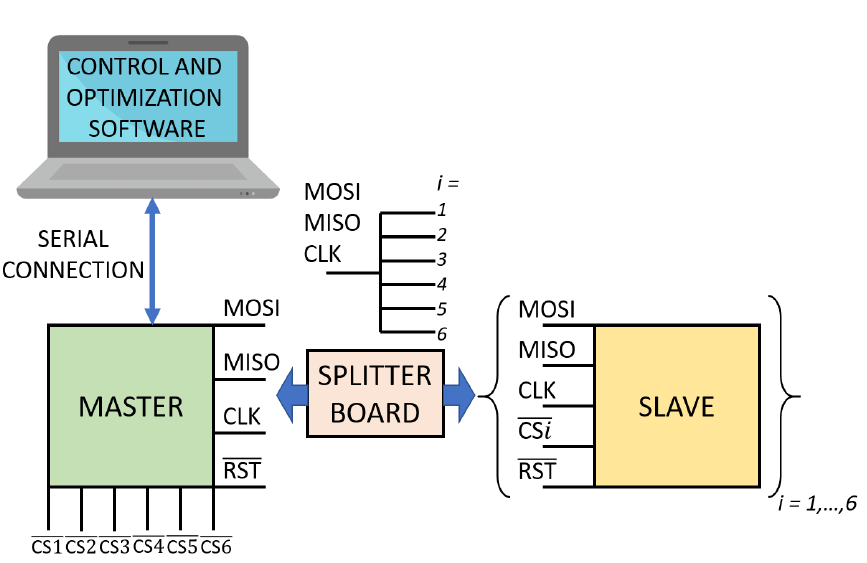
Figure 5. The basic functional scheme of the system: signal acquisition from RXs is performed by a network of slave microcontroller units (MCUs). Slaves are controlled by a central master MCU that triggers data acquisition on all slaves and reads all acquired data. Master–slave communication is based on an Serial Peripheral Interface (SPI) bus with star topology. Data are read from the master using a control software running on a standard PC; the same software uses the data to solve the optimization problem and to estimate position and attitude of all TXs.